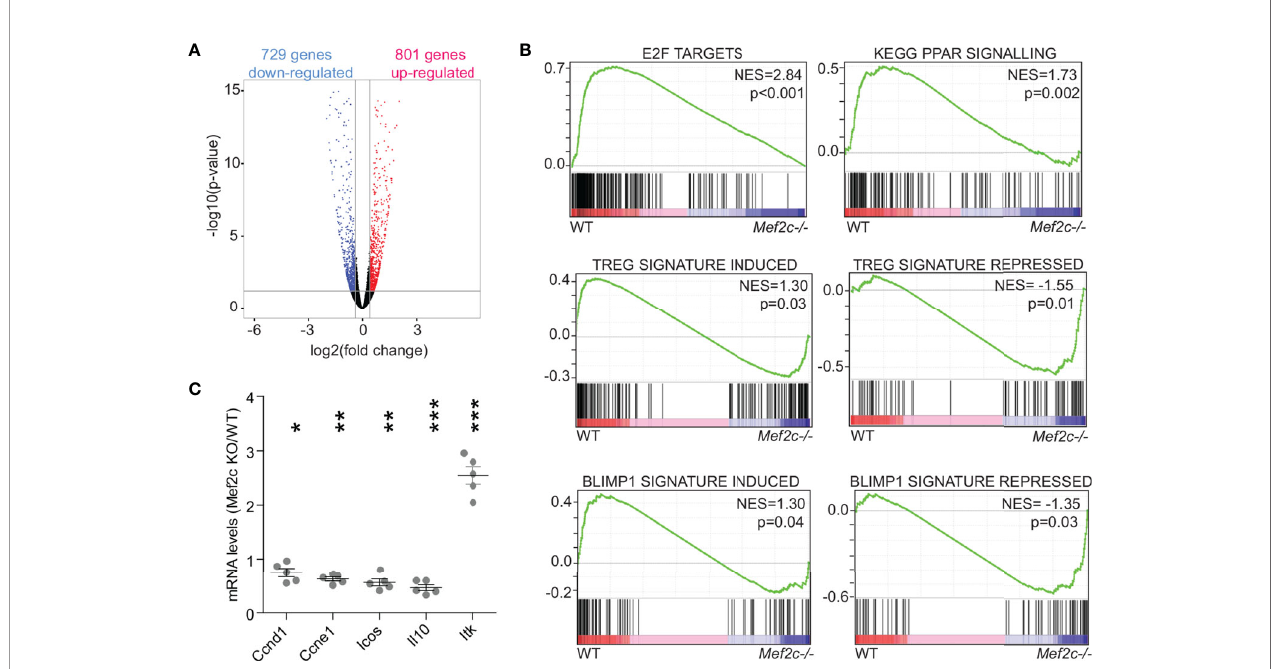
FIGURE 2 | General Mef2 signatures but also Treg-speci fi c signatures are altered in Mef2c-/- Tregs. (A) Volcano plot illustrating the statistical signi fi cance and the fold change for genes differentially expressed in Mef2c-/- Foxp3+ Tregs in respect to WT Treg cells. (B) GSEA plots obtained by using the indicated gene-sets and as dataset the transcriptome of WT or Mef2c-/- Tregs. (C) mRNA expression levels of the indicated genes, expressed as a ratio between Mef2c-/- and WT Tregs (t-test between the two groups for each gene, *p < 0.05, **p<0.01,